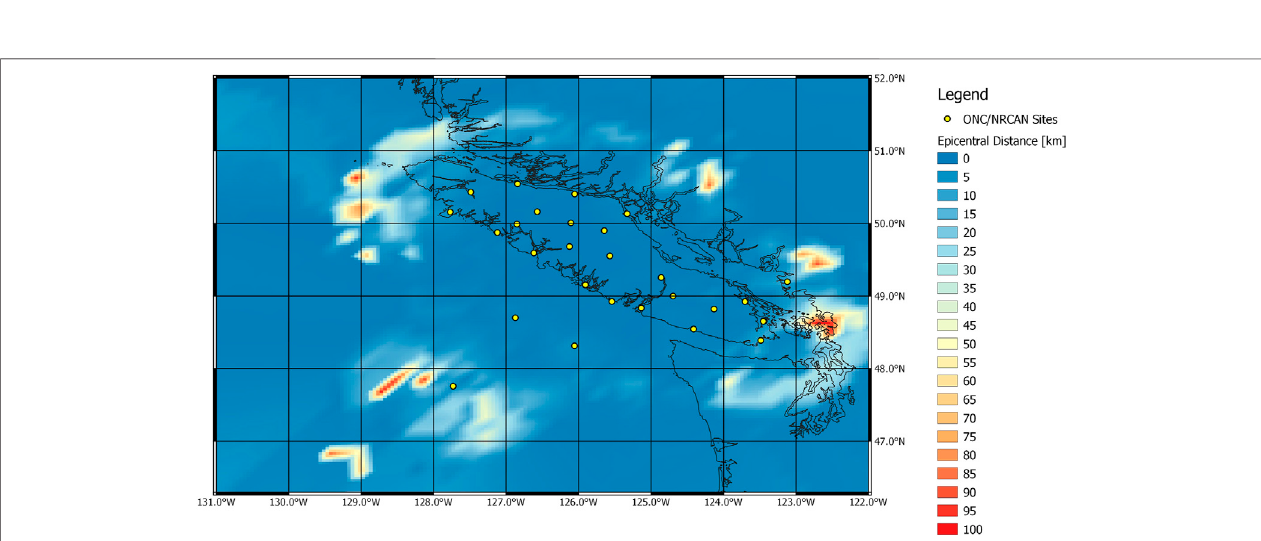
FIGURE7| Thedistributionoferrorsinepicentraldistancesfromthecombinedalgorithmsafterthe fi rsttenstationshavedetectedtheP-wavearrival.Yellowcircles mark the location of the seismic stations that were included in the modelling approach.